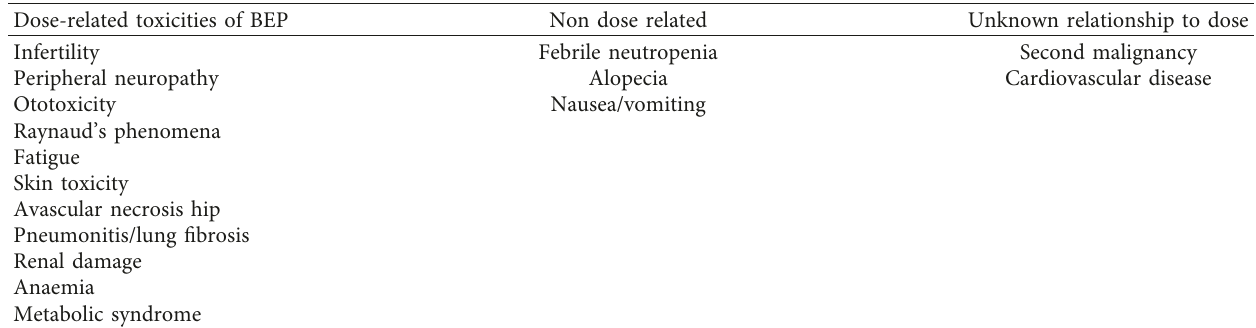
Table 1: Toxicities of BEP